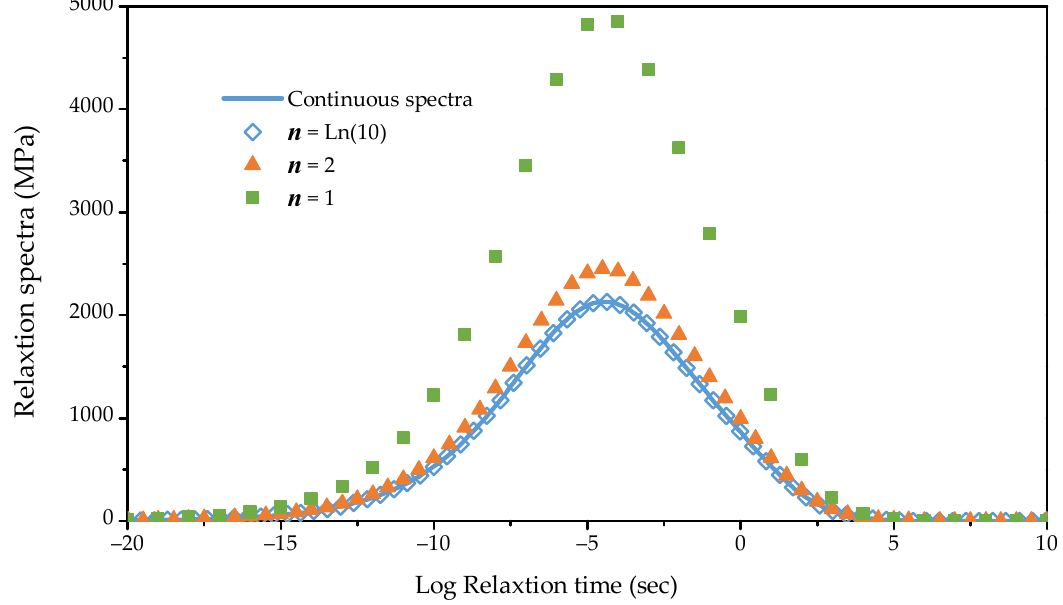
Materials 2019 , 03 , x FOR PEER REVIEW Figure 5. Continuous spectrum and discrete spectrum with di ff erent values of n . Figure 5. Continuous spectrum and discrete spectrum with different values of n .